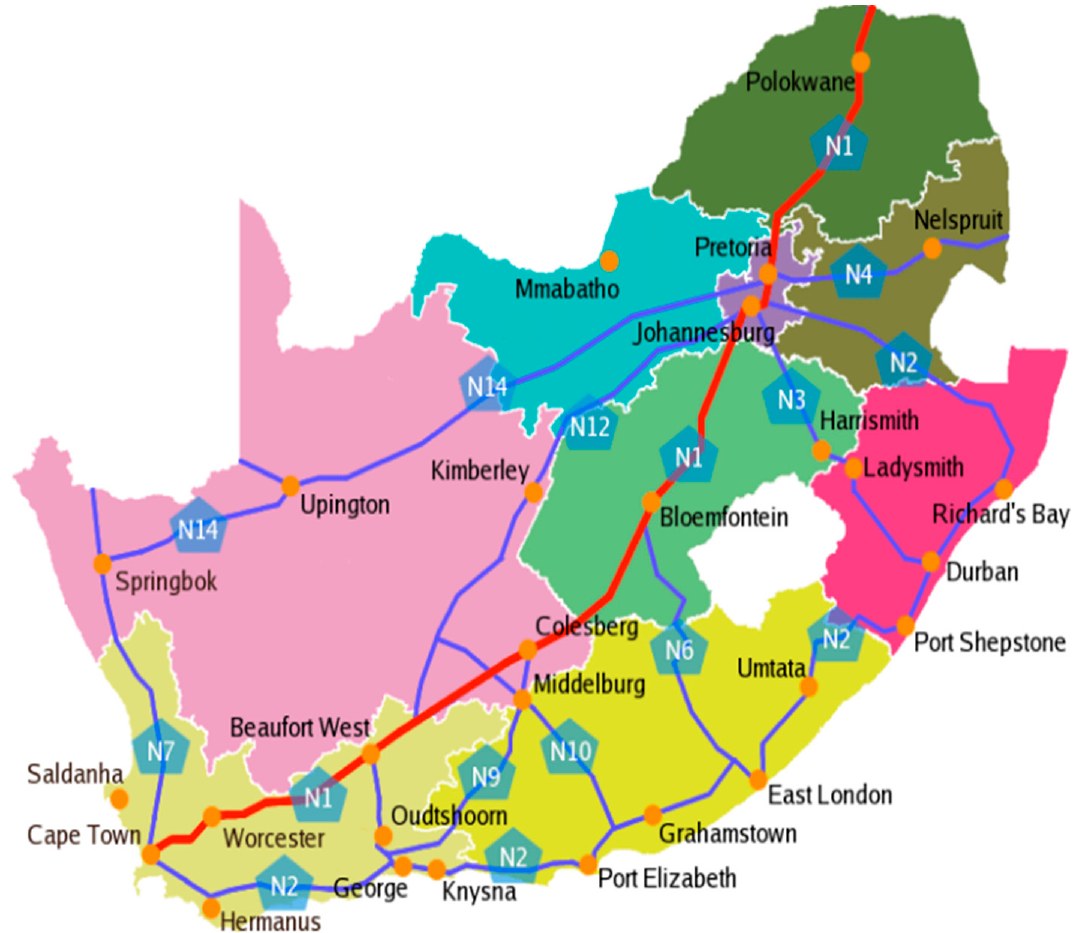
Figure 2. An aerial drone image of the Allandale interchange.